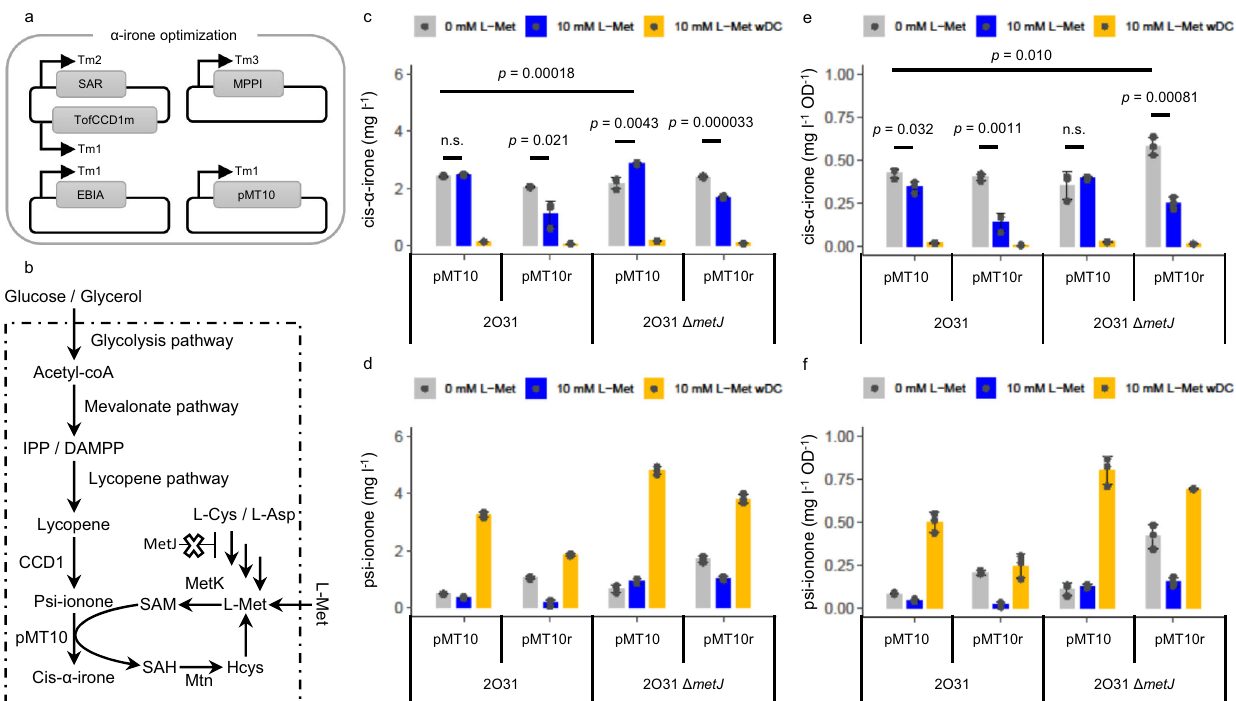
Fig. 4 | Optimizing in vivo production of cis- α -irone from a simple carbon source. a Schematic representation of the plasmids used to produce cis- α -irone (Supplementary Table 3). Four plasmids were used. The fi rst plasmid carried the SAR module, which containedthe uppermevalonate enzymes: HMG-CoA synthase (HmgS), acetoacetyl-CoA thiolase (AtoB) and truncated HMG-CoA reductase (tHmgR), and engineered OfCCD1 fused with thioredoxin (TofCCD1m) 10 . The sec- ond plasmid carried the MPPI module, which contained the lower mevalonate enzymes: mevalonate kinase (MevK), phosphomevalonate kinase (PMK), mevalo- nate pyrophosphate decarboxylase (PMD) and isopentenyl pyrophosphate (IPP) isomerase (Idi). The third plasmid carried the lycopene synthesis EBIA module: geranylgeranyl pyrophosphate (GGPP) synthase (CrtE), phytoene synthase (CrtB), phytoene desaturase (CrtI) and farnesyl pyrophosphate (FPP) synthase (IspA). The fourth plasmid carried the pMT10 enzyme or pMT10 with the SAM cycle enzymes: S -adenosylmethionine synthase (MetK)and S -adenosylhomocysteine nucleosidase